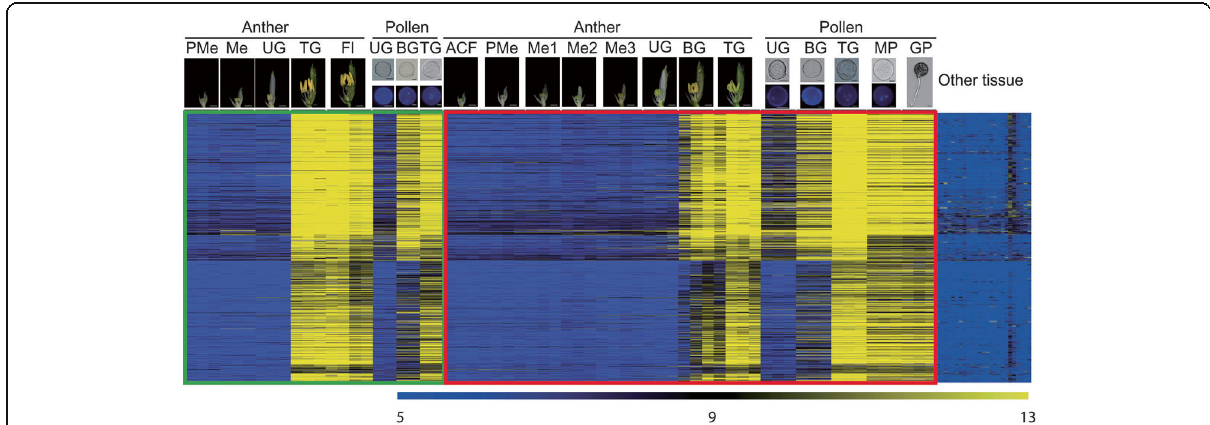
Fig. 1 Heatmap expression analysis of 627 late pollen-preferred genes. Expression patterns conserved among indica (green box) and japonica (red box) rice types are shown over several stages of development. Microarray data numbered 22 for indica rice (5 stages for anthers and 3 for pollen) and 42 for japonica rice (8 stages for anthers and 5 for pollen). Anatomical meta-expression data from ROAD were used to check expression patterns in other tissues. ACF, archesporial cell-forming stage; BG, bi-cellular gametophyte stage; Fl, flowering stage; GP, germinating pollen; Me, meiotic stage; Me1, meiotic leptotene stage; Me2, meiotic zygotene-pachytene stage; Me3, meiotic diplotene-tetrad stage; MP, mature pollen stage; PMe, pre-meiosis; TG, tri-cellular pollen stage; UG, uni-cellular gametophyte stage. Yellow color in heatmap indicates high level of expression; dark-blue, low